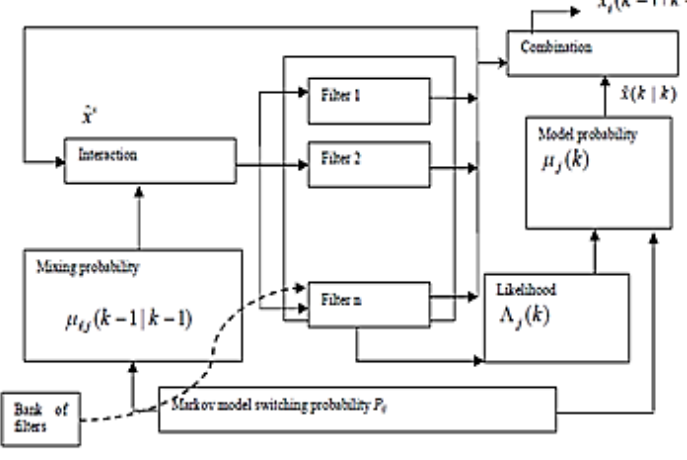
Figure 4. General block diagrams of multi model Kalman filter